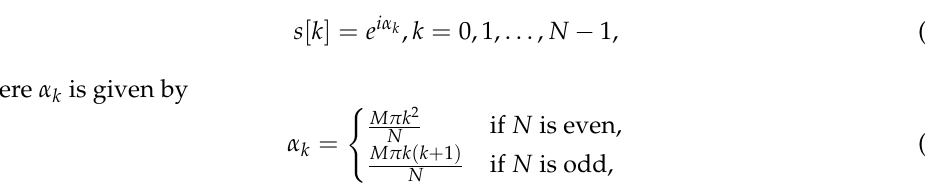
Figure 3. Experimental setup: The designed signal is transmitted via ultrasonic transmitters with the aid of an AWG (arbitrary waveform generator), a DC-power supply, and a driving circuit, and received using ultrasonic receivers with the aid of an oscilloscope. Signal processing takes place in a computer.